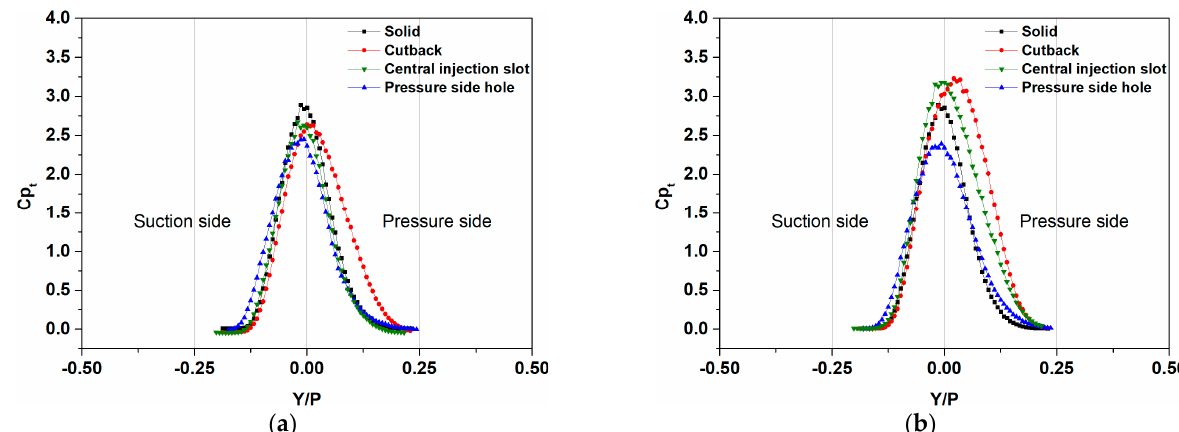
Figure 7. Pitchwise distribution of the total pressure loss coefficient at Z/H = 0: ( a ) for M = 0.0; ( b ) for M = 3.0.